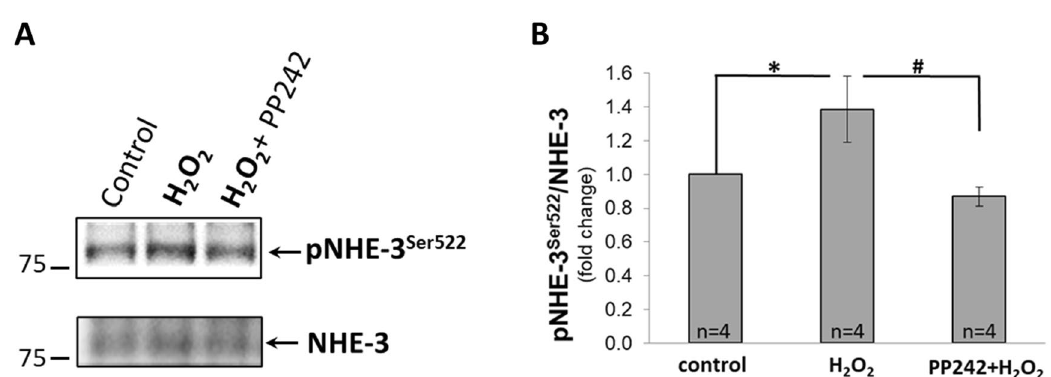
Figure 7. ( A ) Representative Western Blot of phosphorylated NHE-3 (pNHE-3 Ser522 ) and total NHE-3 in mTAL isolated from SD rats. mTAL incubated in HBSS for 20 min ( control ); incubated 10 min in HBSS and then with 100 µM of H 2 O 2 for another 10 min ( H 2 O 2 ); incubated with 10 µM of PP242 for 10 min and with 100 µM of H 2 O 2 for another 10 min ( H 2 O 2 + PP242 ). ( B ) Activity of NHE-3 determined by densitometric quantification expressed as the ratio of pNHE-3 Ser522 relative to total NHE-3. Data were normalized to control and represented as mean ± S.E.M (n = 6). * P < 0.05 between control and H 2 O 2 treated mTAL, # P < 0.05 between H 2 O 2 treated and